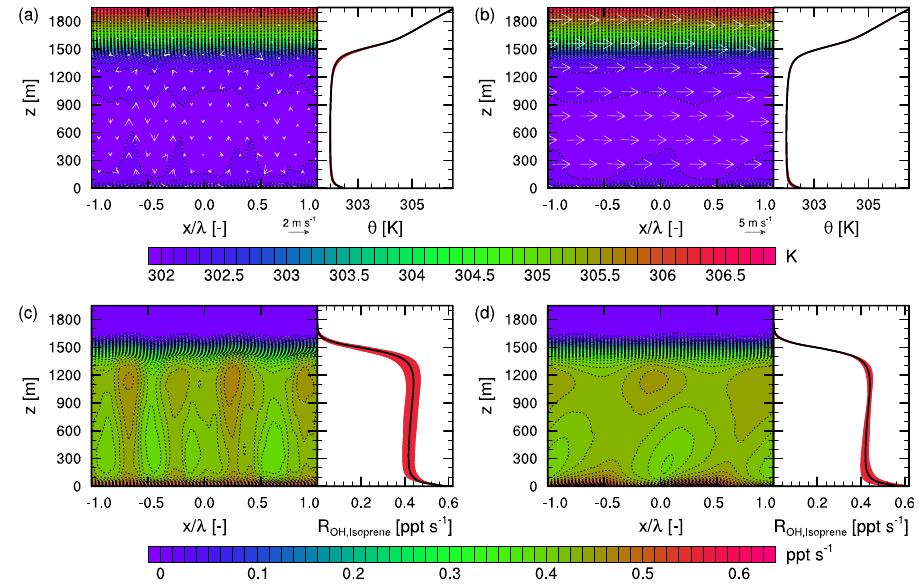
Fig. 7. Potential temperature and chemical reaction rate for Reaction (R9) for the numerical experiments WU2 (a, c) and WX2 (b, d) . WU2 evaluates a homogeneous surface forcing with a background wind of 5ms − 1 in the positive y-direction. In the numerical experiment WX2 a heterogeneous surface forcing is applied with a background wind of 5ms − 1 in the positive x-direction. The potential temperature, θ , is shown on top (a, b) and the chemical reaction rate, R OH , Isoprene , below (c, d) . Each figure consists of two panels. The first panel shows these variables averaged over the fourth hour of simulated time and the y-direction, while the second panel shows an additional average in the x-direction. The red area in the second panel shows the variability in the x-direction of the temporal and y averaged values. Wind direction in the xz-plane and its magnitude are indicated by vectors (a, b) . The x-coordinate is scaled by the length scale of heterogeneity, λ , which is twice the patch